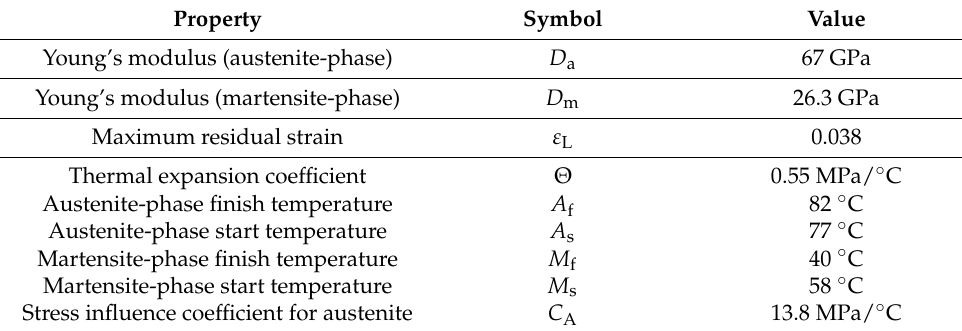
Table 1. SMA material properties.